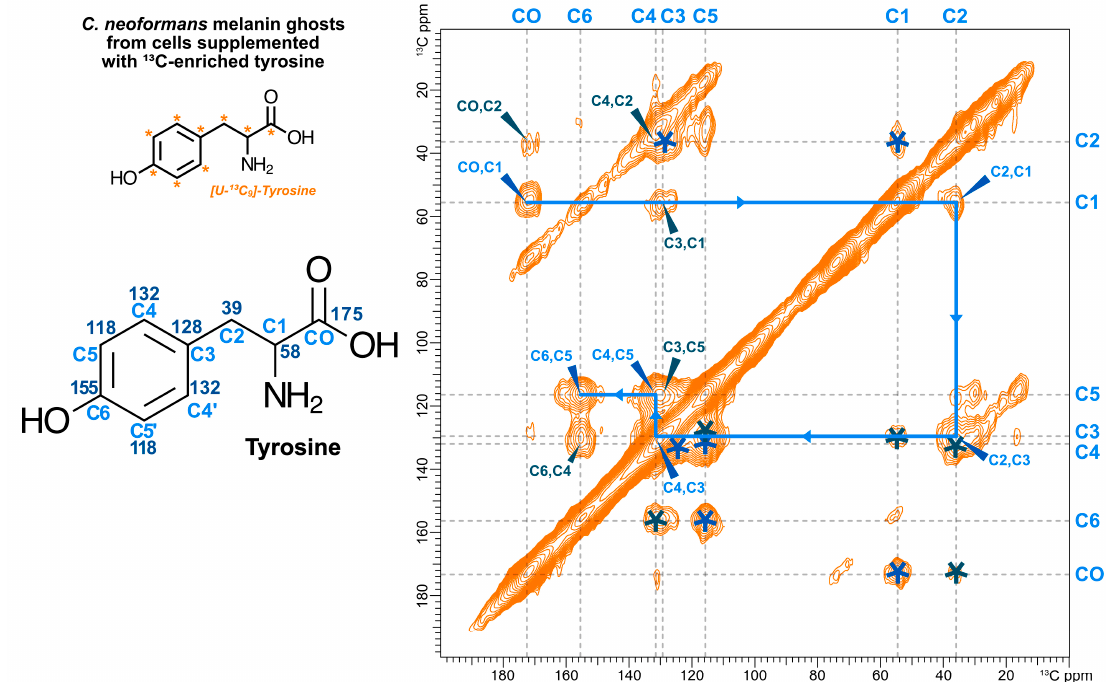
Figure 4. 2D 13 C- 13 C DARR spectrum (50 ms mixing time) of C. neoformans melanin ghosts generated from a cell culture supplemented with 0.5 mM [U- 13 C 9 ]-tyrosine that contained natural abundance glucose and l -DOPA as the sole carbon source and obligatory melanization precursor, respectively. The cross-peaks displayed correspond to proximal carbon pairs within tyrosine separated by 1 bond (blue) or 2 bonds (navy). Each 13 C- 13 C pair is annotated with its carbon assignment on one side of the diagonally symmetrical DARR plot and with an asterisk on the other. The blue arrowed line highlights the one-bond connectivities within tyrosine that indicate the molecule did not undergo any chemical modifications. The numbers on the structure at the left indicate the expected chemical shift for each carbon.